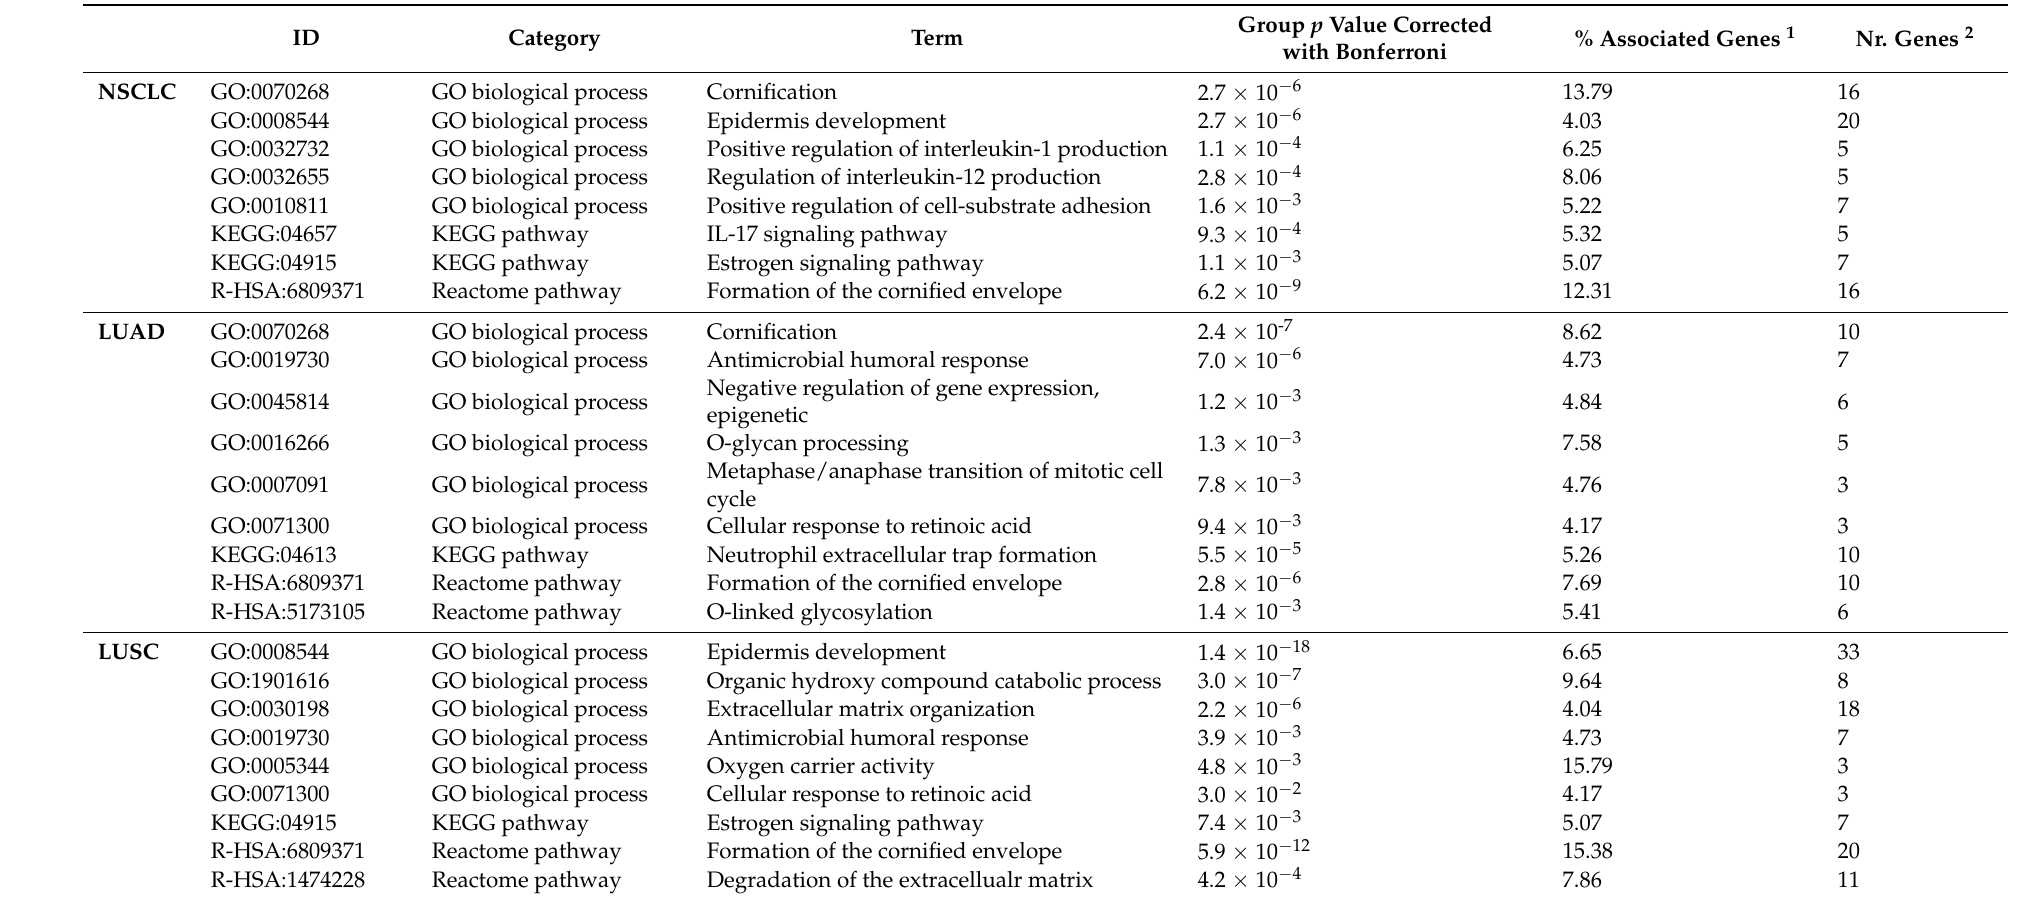
Table 4. Major enriched GO, KEGG, and REACTOME terms in NSCLC and its subtype LUAD and